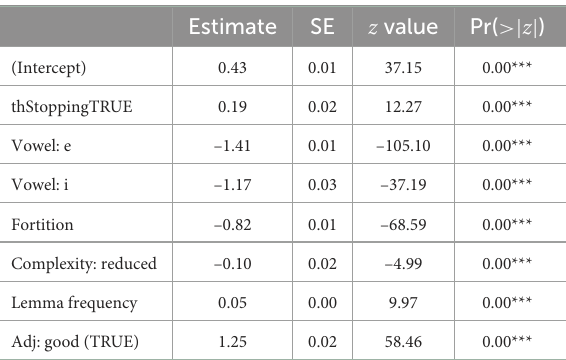
TABLE 1 Results of logistic regression on the full data set. TABLE 2 Results of logistic regression on the subset of data comprising authors who tweeted